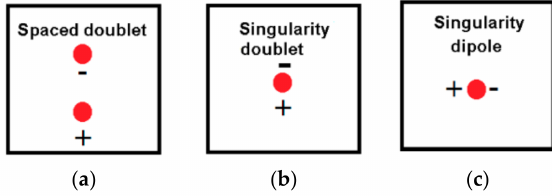
Figure 6. Schematic of ( a ) Spaced doublet, ( b ) Singularity doublet, and ( c ) Rotated singularity doublet gives a singularity dipole to string into a line dipole as used in Section 2.4. Reproduced with permission from